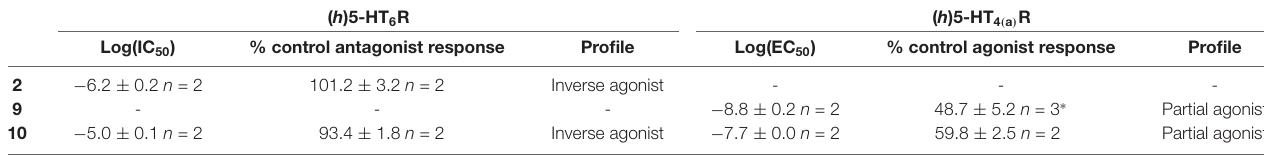
TABLE 3 | ( h )5-HT 6 R and ( h )5-HT 4 ( a ) R pharmacological profile of compounds 2 , 9 and 10 .